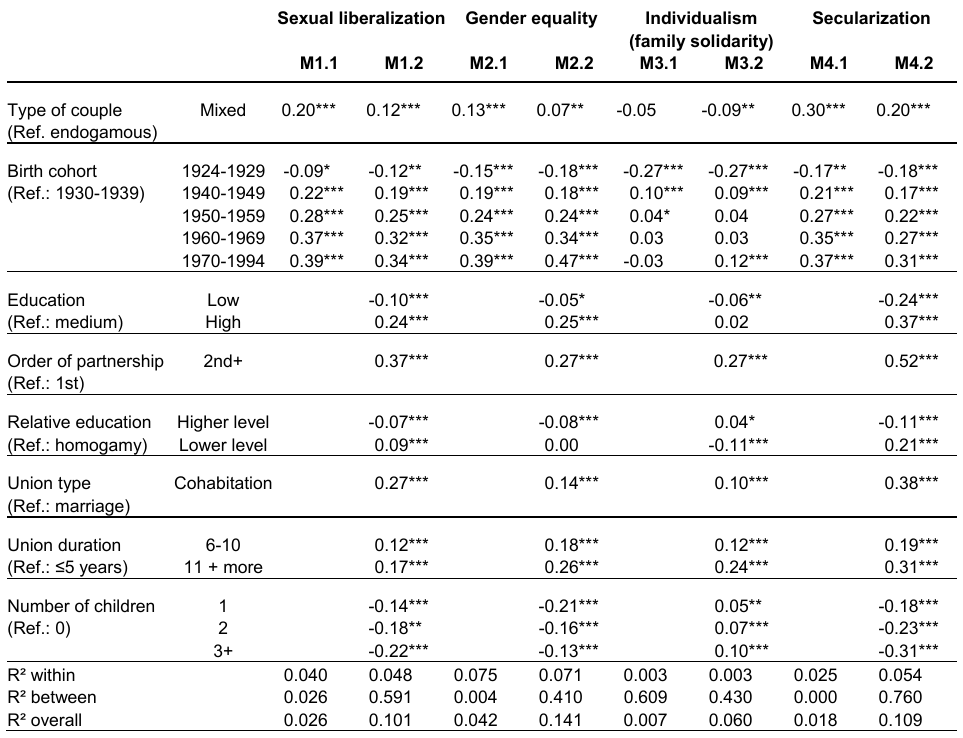
Table 2.2 : Results of linear regression models for attitudes among native men